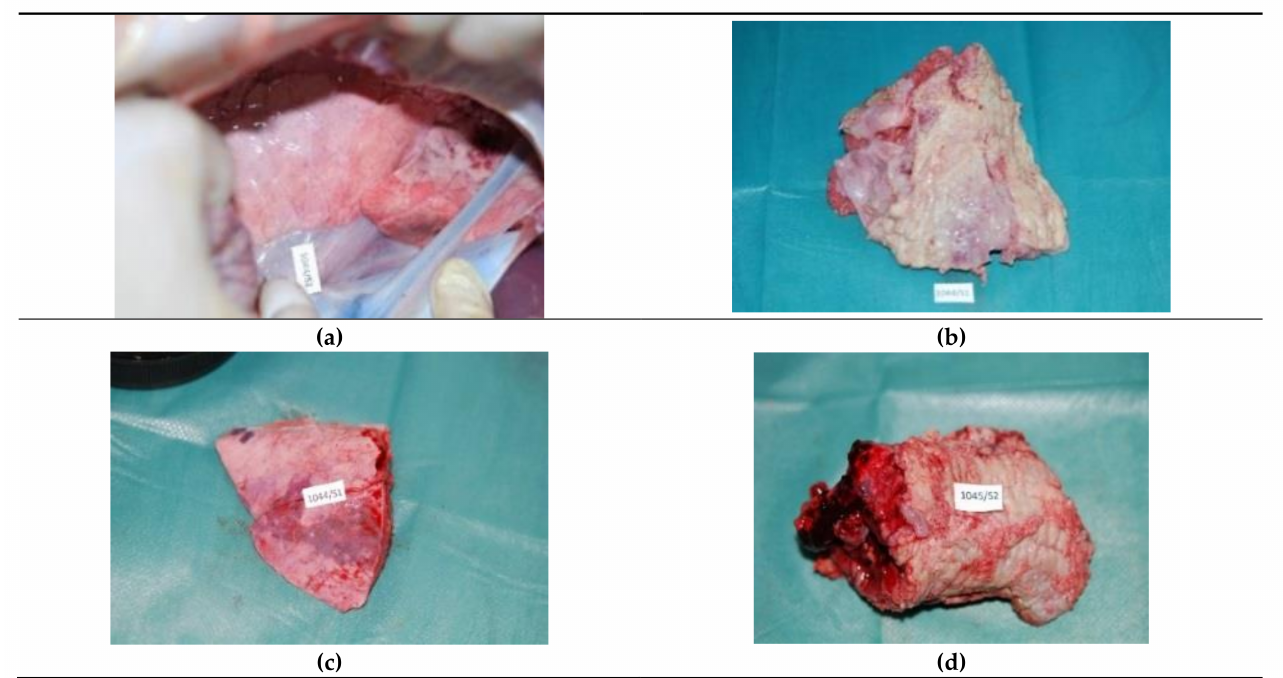
Figure 2. Macroscopic image of pig lungs on day seven after experimental laser surgery: ( a , b ) lung tissue after thulium- doped fiber laser (TDFL) partial resection; adhesion with diaphragmatic pleura is visible ( a ); ( c , d ) lung fragment after partial resection with diode laser